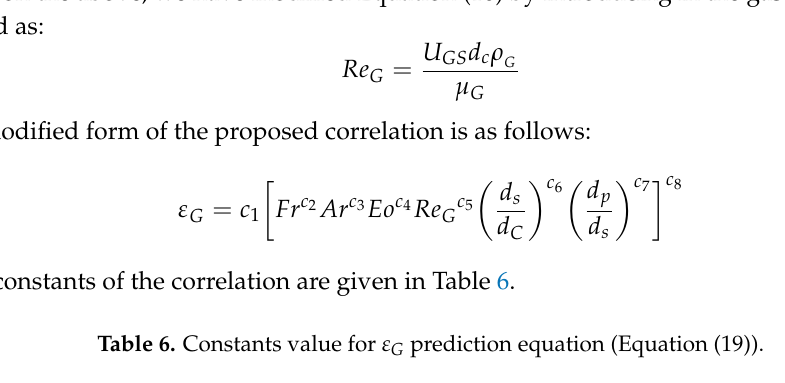
prediction equation (Equation (25)). G